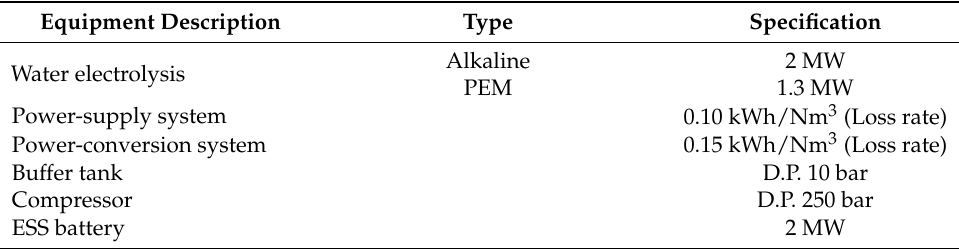
Table 3. Specification for water-electrolysis